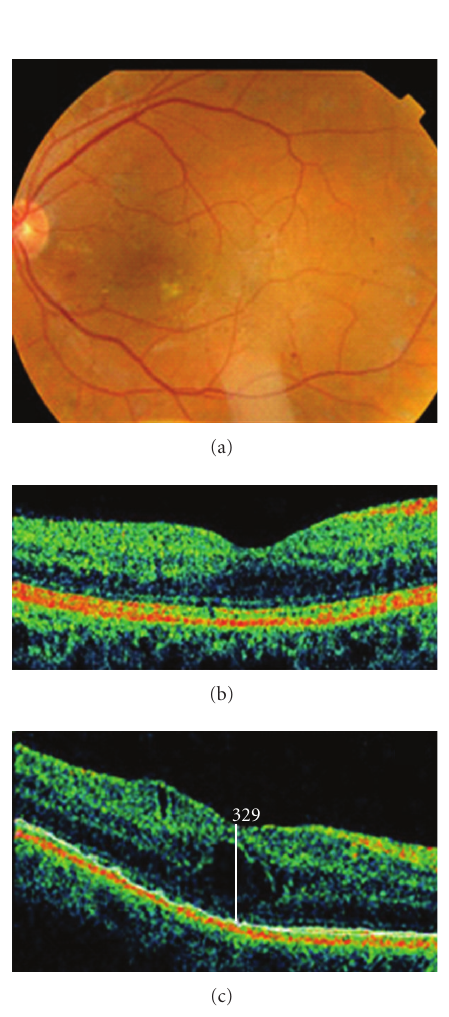
Figure 1: (a) fundus image corresponding to a patient enrolled in the control group that did not receive the prophylaxis after the cataract surgery (b), (c): OCT images of this patient showing the important increase of macular thickness after the cataract surgery without any